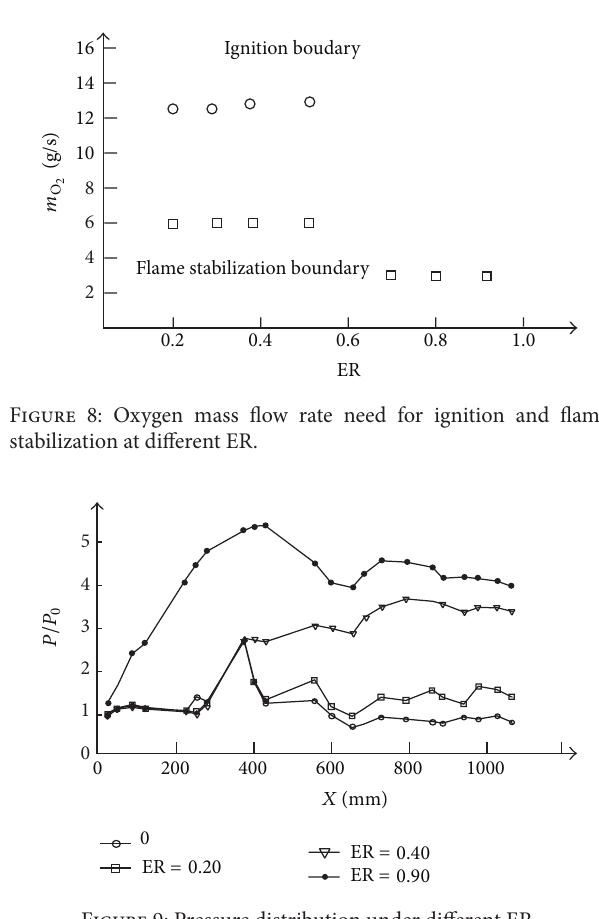
Figure 9: Pressure distribution under different ER.